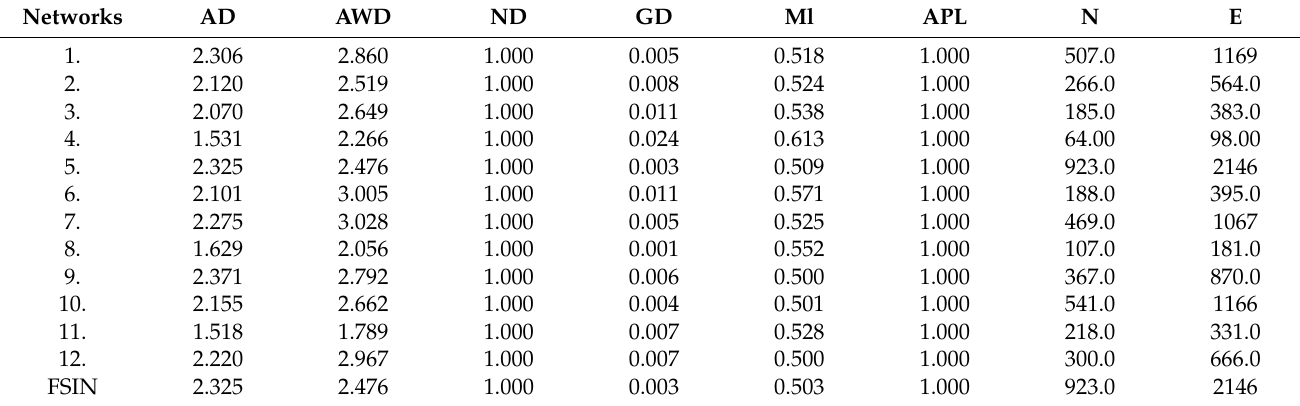
interacted network as illustrated in Figure 2 was generated from 457 compounds having higher modularity class in 12 networks based on the aforementioned parameters. Repulsion strength was set to 10,000, and Force Atlas and Fruchterman rein gold layouts were used to display and visualize the networks. Table 2. Statistical parameters used to predict network interactions of various natural and synthetic compounds. Networks